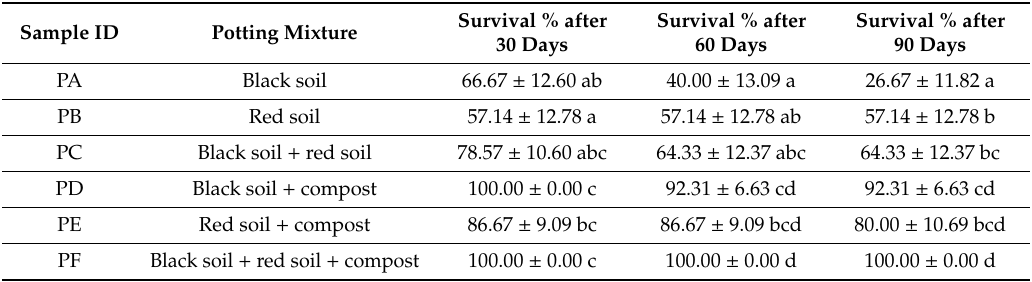
Table 3. Acclimatization of regenerated plantlets of Orthosiphon stamineus .